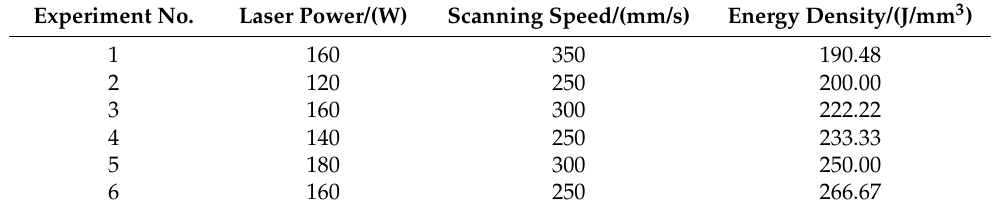
Table 5. Process parameters of interlayers. Experiment No. Laser